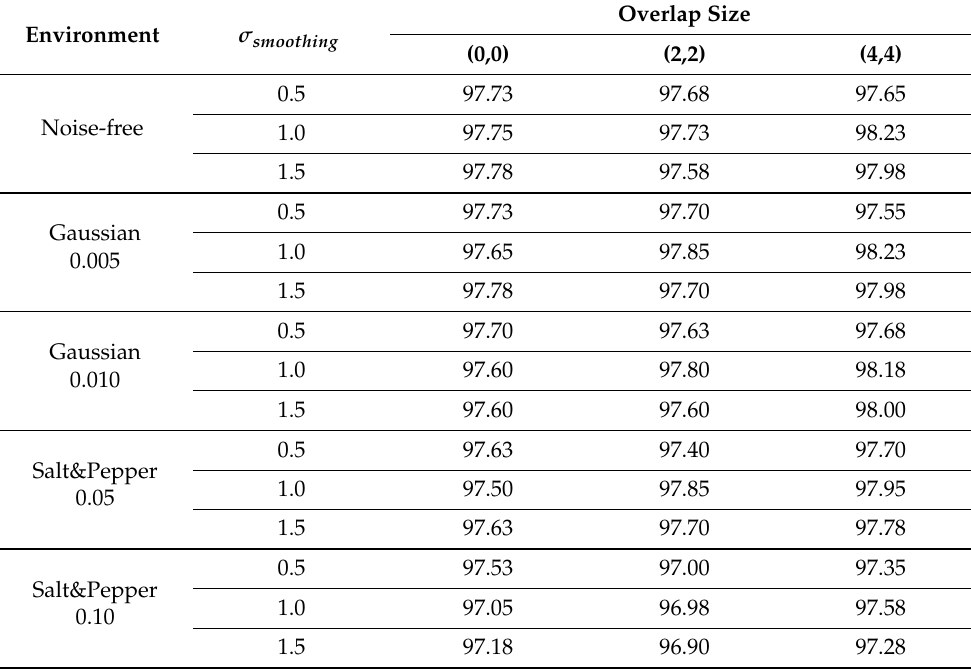
Table 1. ORL recognition rates (%) under different